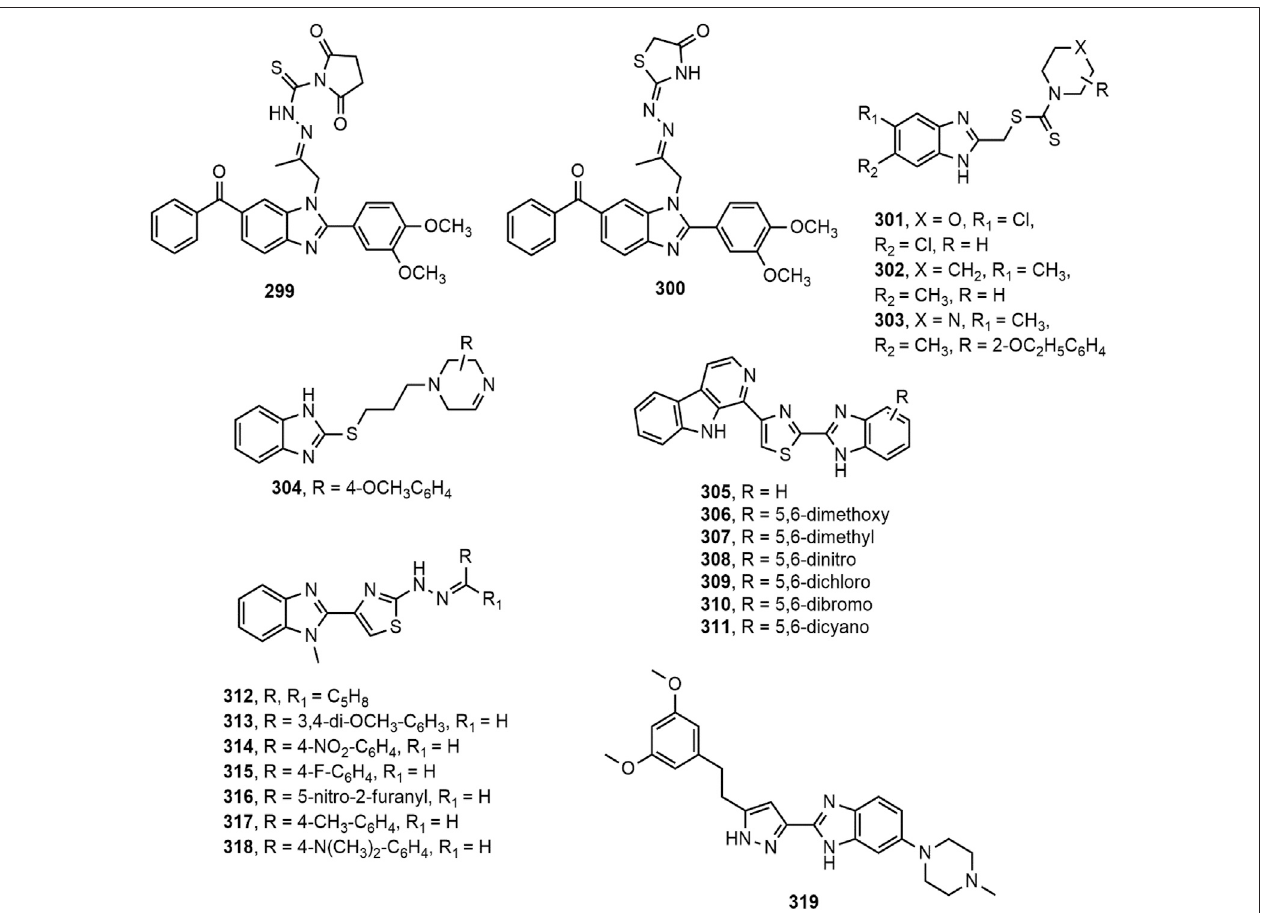
FIGURE 10 | Benzimidazole derivatives with anticancer